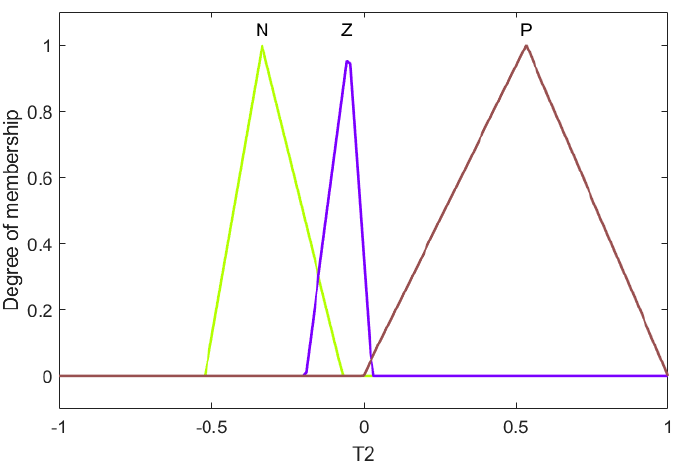
Figure 16. Membership functions for Output 2.